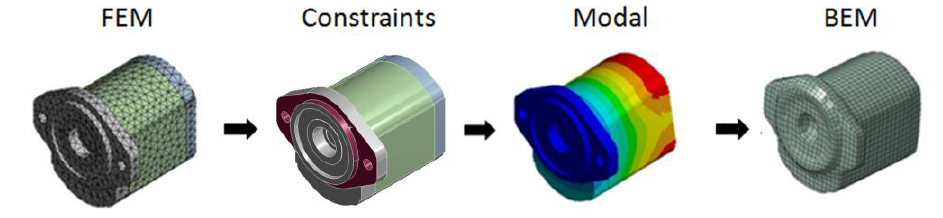
Figure 13. Structural model path.